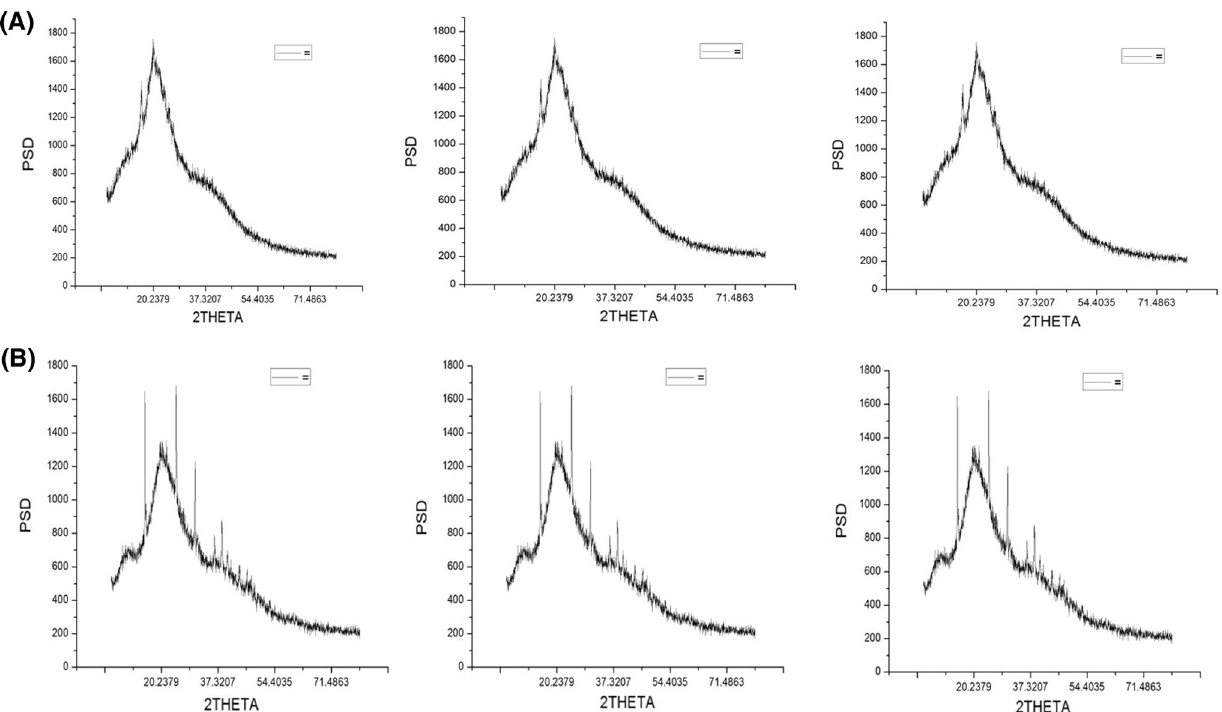
Fig. 1 a Powder XRD patterns of the three adsorbents before adsorption, b powder XRD patterns of the adsorbents after adsorption with